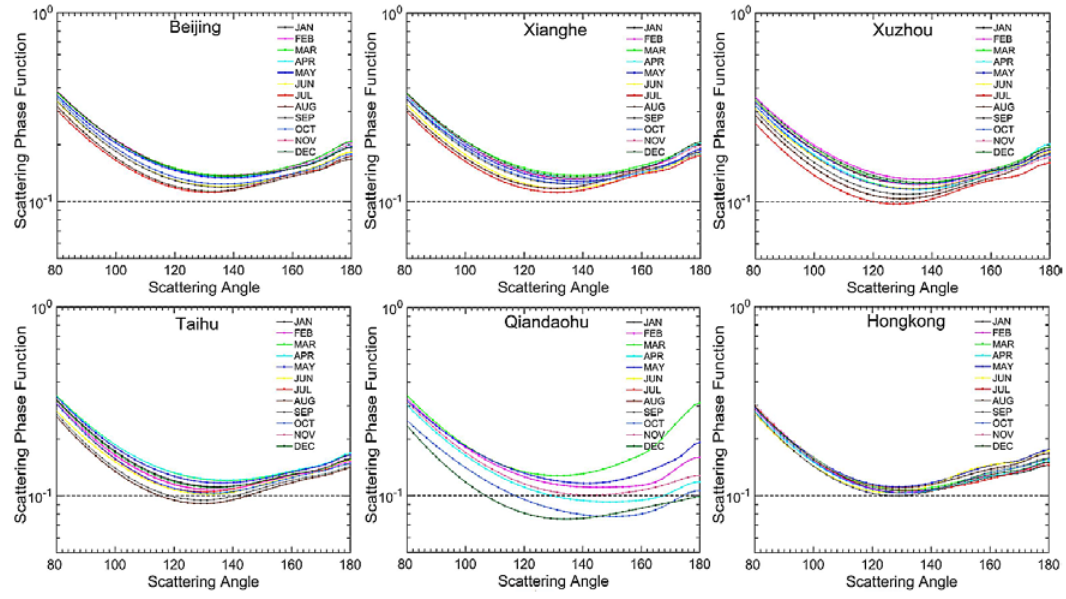
Figure 4. Monthly mean values of scattering phase function at 440 nm in eastern China.